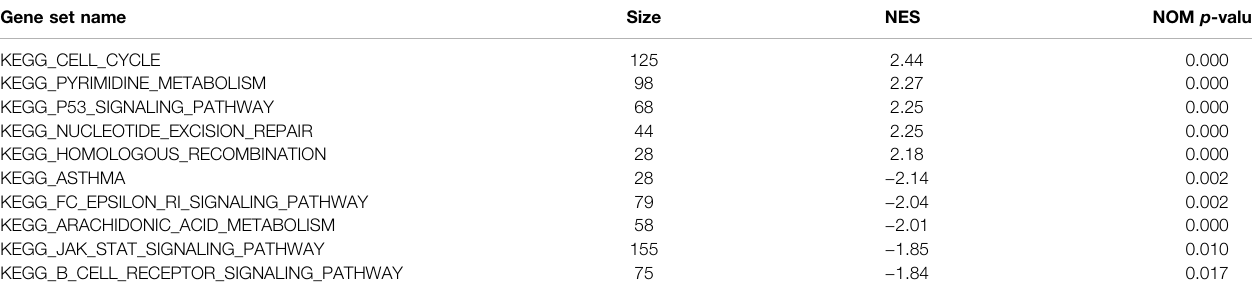
TABLE 3 | Gene functional enrichment in high- and low-risk groups.